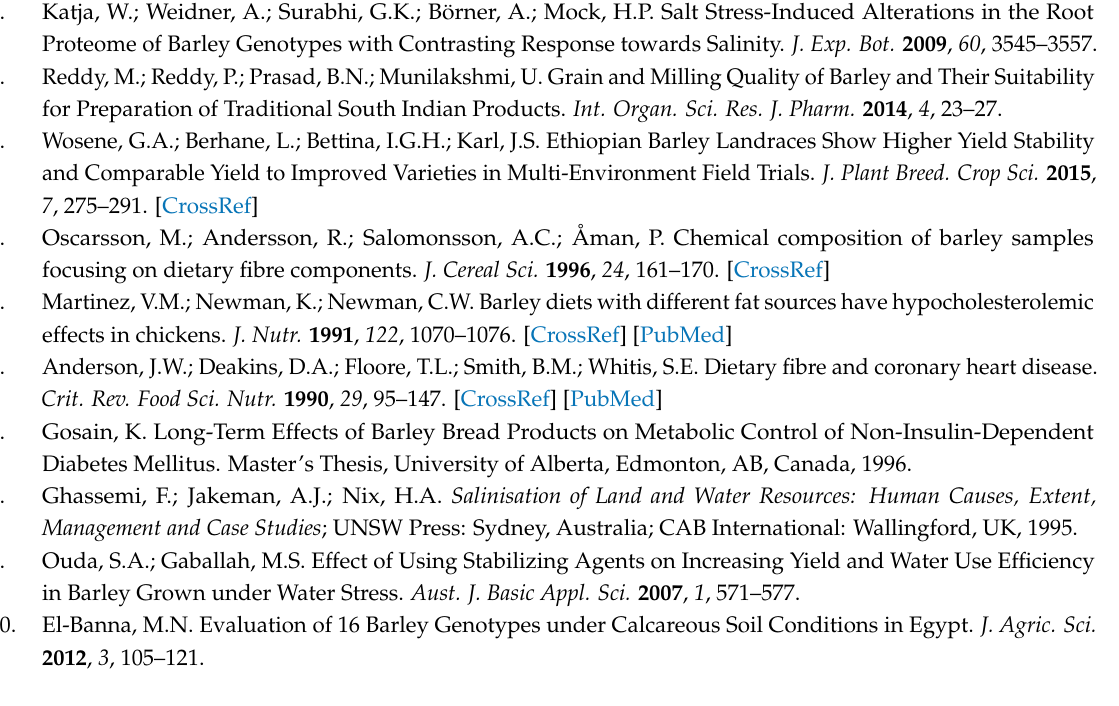
Table S1: Physical and chemical soil properties for E1 (El-Nubaria station 2015/2016), E2 (El-Bostan 2015/2016) and E3 (El-Bostan 2016/2017). Table S2: Meteorological parameters for E1 (El-Nubaria station 2015/2016), E2 (El-Bostan 2015/2016) and E3 (El-Bostan 2016/2017). Table S3: Genotypes means for the number of days to flowering (days) and plant height (cm), under three environments, E1 (El-Nubaria station 2015/2016), E2 (El-Bostan 2015/2016) and E3 (El-Bostan 2016/2017). Table S4: Genotypes means for number of grains/spike, 1000- grain weight (g) and grain yield (tons/ha), across E1 (El-Nubaria station 2015/2016), E2 (El-Bostan 2015/2016) and E3 (El-Bostan 2016/2017). Table S5: Genotypes means for total chlorophyll (Spad unit) and leaf area (cm 2 ), under three environments, E1 (El-Nubaria station 2015/2016), E2 (El-Bostan 2015/2016) and E3 (El-Bostan 2016/2017). Table S6: Genotypes means for leaf rust, net blotch, and powdery mildew, across E1 (El-Nubaria station 2015/2016), E2 (El-Bostan 2015/2016) and E3 (El-Bostan